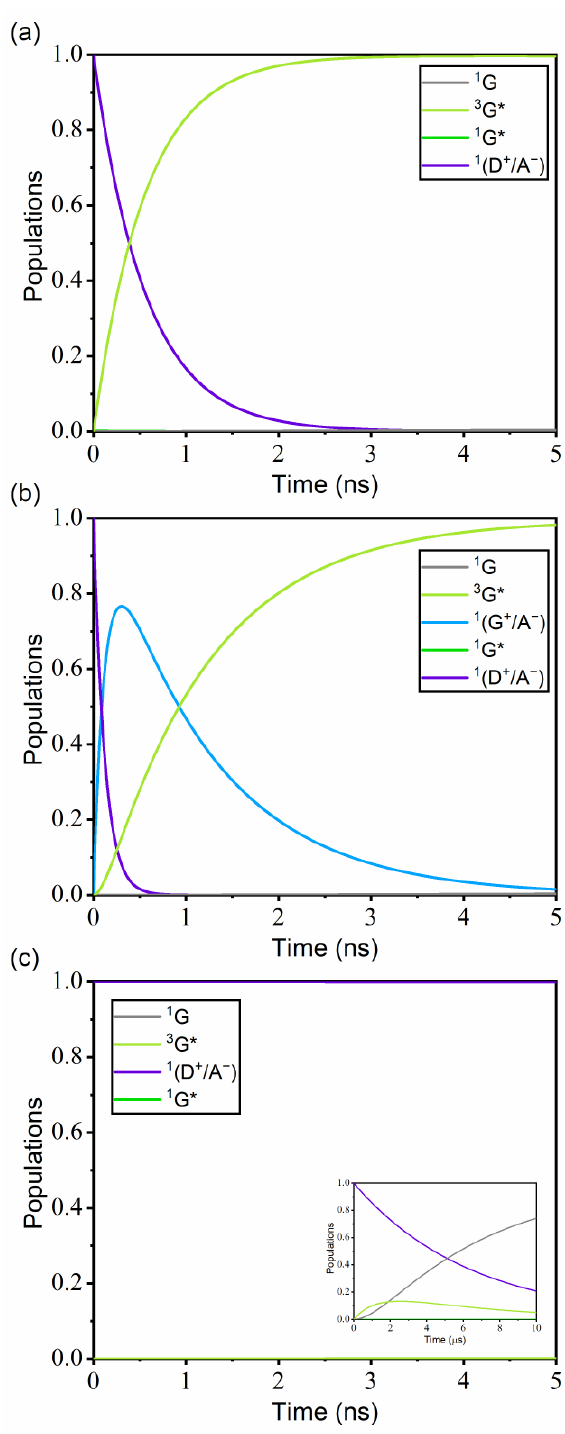
Figure 8. Population changes of the considered electronic states for ( a ) 1 (Ir(ppy) 3 /TCTA/TPBI), ( b ) 1 (TCTA/TPBI/Ir(ppy) 3 ), and ( c ) 1 (TCTA/Ir(ppy) 3 /TPBI) with the assumption that the initiating state is the lowest 1 (D + /A − ) state. Inset in ( c ) shows the data in the long-time limit. Except the ground state 1 G, the population of each electronic state represents the sum of all populations of the states belonging to that type of electronic state. For example, the 1 G* population includes all singlet excited populations of G. The considered electronic states are listed in Table S1. Rate constants were calculated with the Förster theory at 300 K, using the reorganization energy of 2000 cm − 1 .